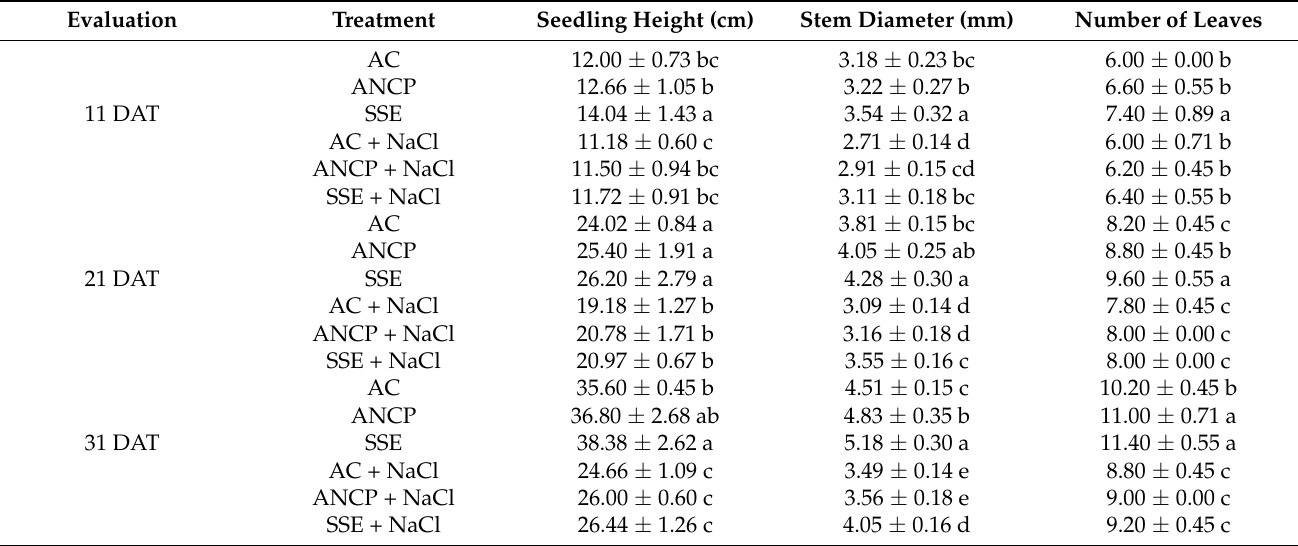
Table 1. Growth parameters of tomato